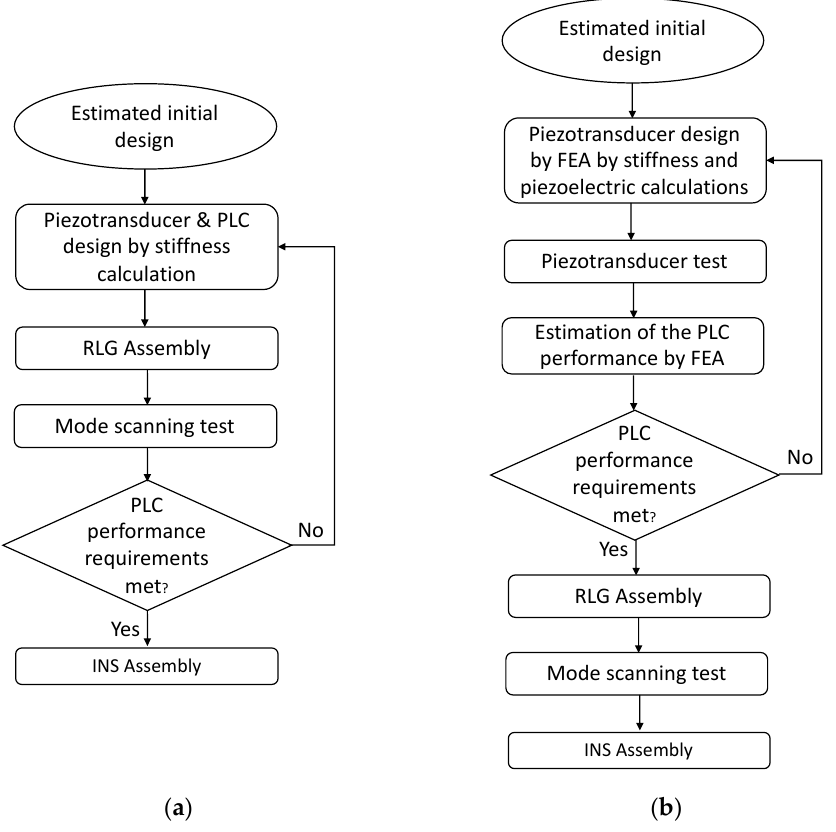
Figure 2. Flowcharts of the PLC design framework: ( a ) conventional; and ( b ) combined computational–experimental frameworks .